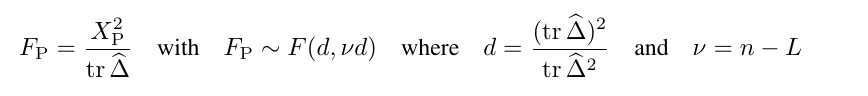
170 svy: tabulate twoway — Two-way tables for survey